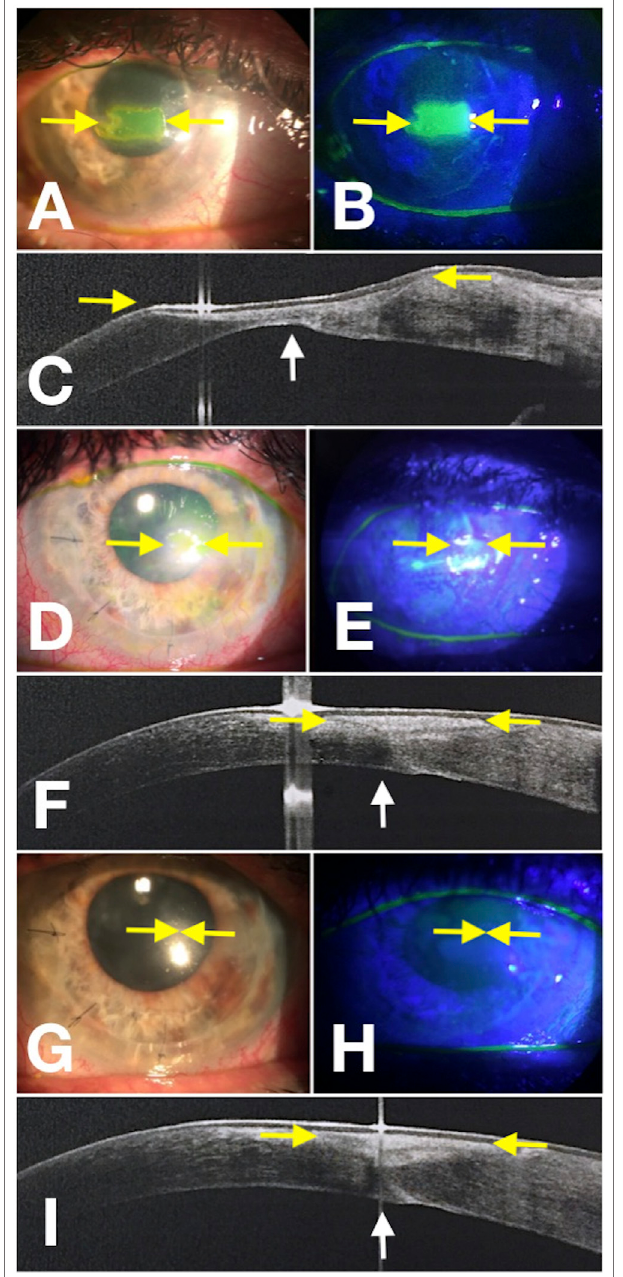
FIGURE 4 | Corneal wound healing of neurotrophic corneal ulcer (rh- NGFCase6)imagedwithamultimodalapproach.Yellowarrowspointatthe edges of the epithelial fronts in the photograph obtained at baseline with diffuse white light (A) , with fl uorescein staining (green) photograph obtained under cobalt-blue lightillumination (B) , and points tothe ulcer area in the OCT scan detected over the thinnest area at baseline (C) . (D – F) Images show the progression at Week 4, and the yellow arrows point to the epithelial edges. (G – I) Images were acquired at the end of the treatment at Week 8. The white arrows point to the change in CT detected by the AS- OCT scan (C,F,I) .